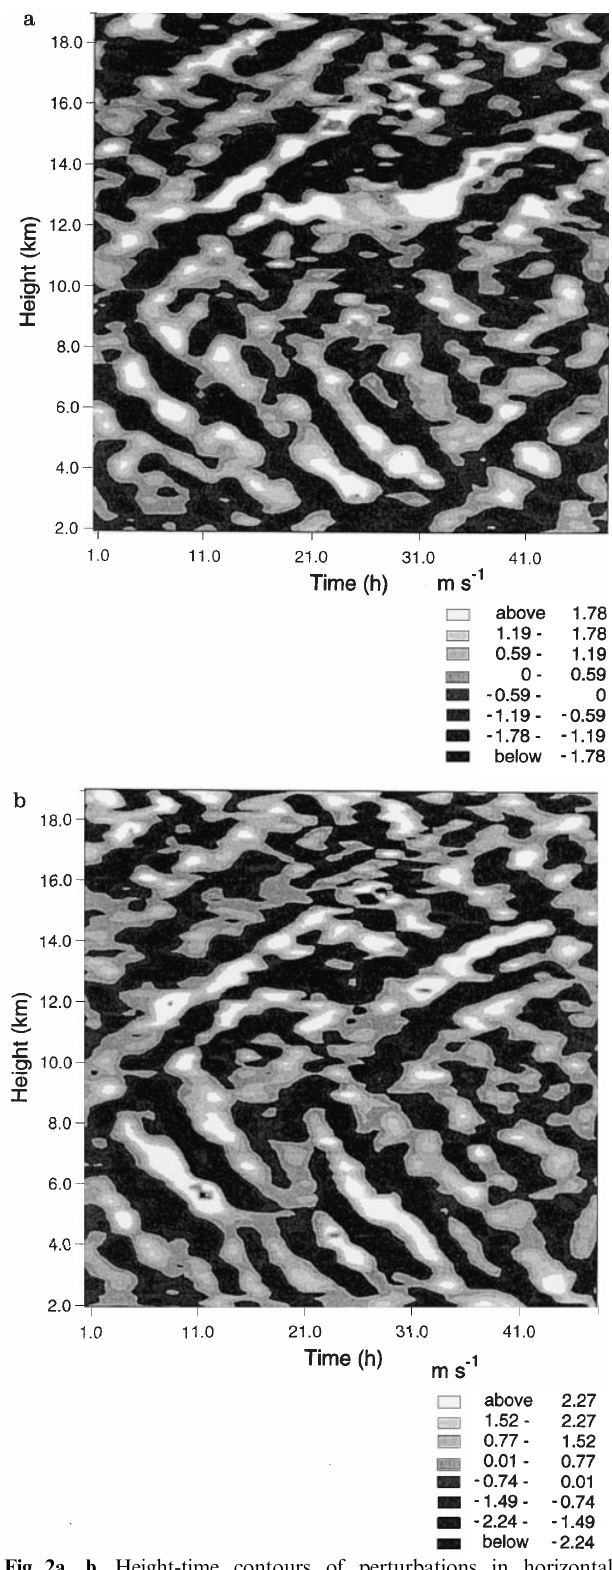
Fig. 2a, b. Height-time contours of perturbations in horizontal velocity in m/s for a zonal component and b meridional component, for 12–13 March, 1994